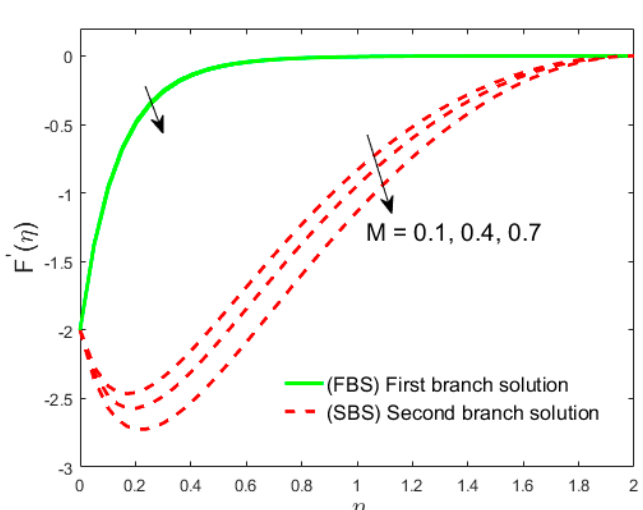
Figure 4. The impact of W on F (cid:48) ( η ) .